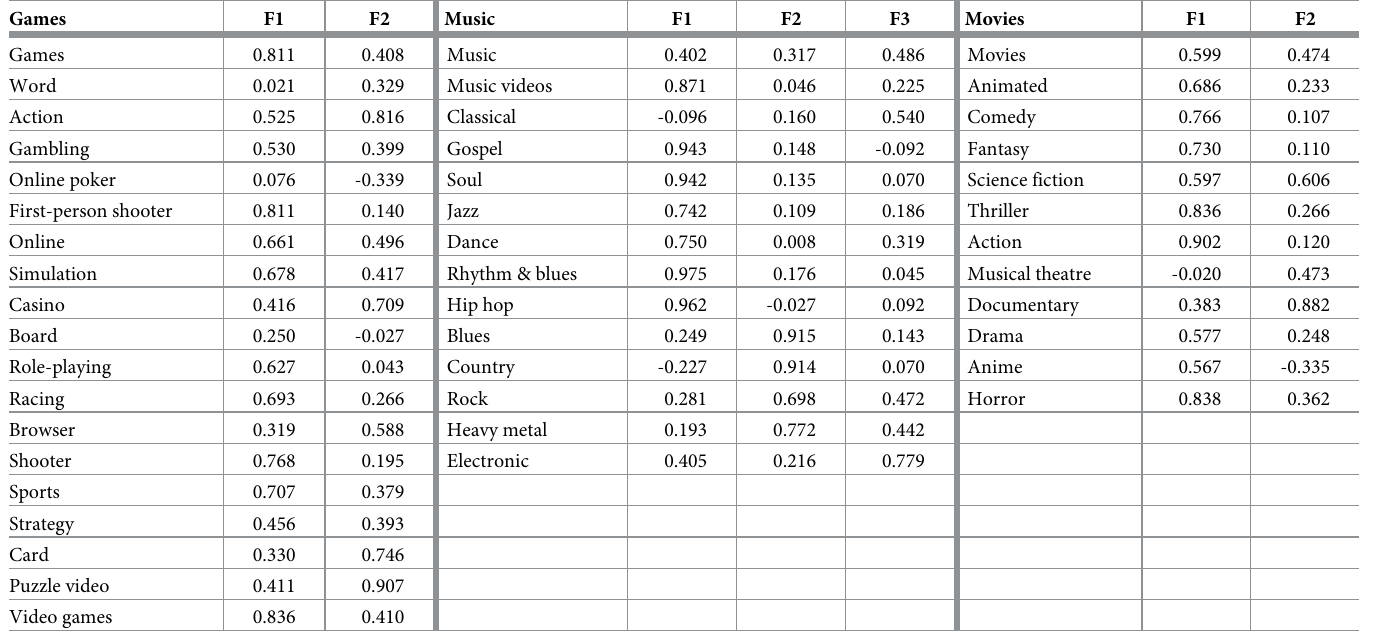
Table 1. Factor analysis of the Facebook interest related variables.